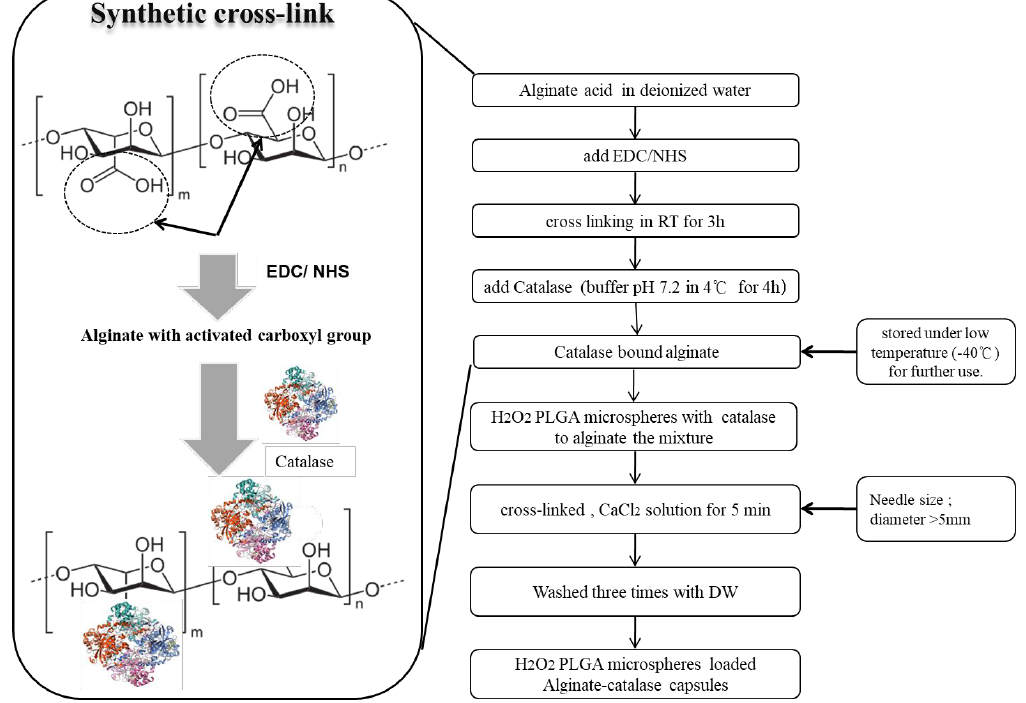
Figure 2. Fabrication process of H 2 O 2 PLGA microspheres loaded alginate-catalase capsules.